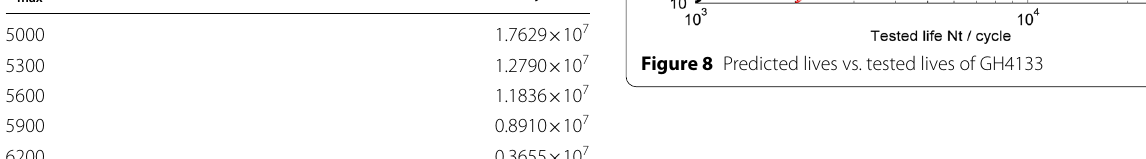
Table 4 Contact fatigue experimental data for GCr15 at R σ max (MPa) Nt (cycles)